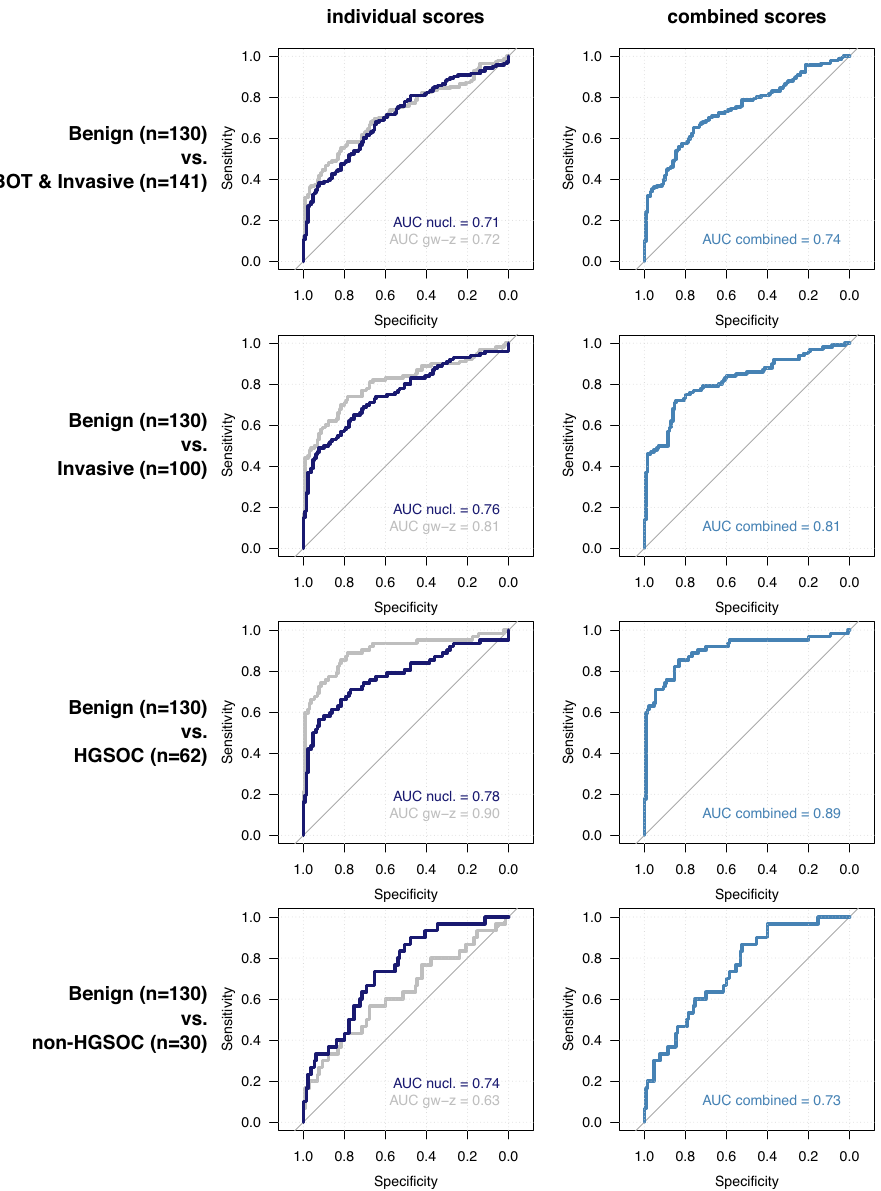
Fig. 3 ROC analysis. ROC curves for nucleosome scores ( “ nucl. ” ) and genome-wide z -scores ( “ gw- z ” ) to discriminate patients with benign ovarian disease ( n = 130) from patients with borderline (BOT) and invasive carcinoma ( n = 141, including 8 patients with metastases; fi rst row); patients with invasive carcinoma ( n = 100; second row); patients with HGSOC disease ( n = 62; third row); patients with non-HGSOC disease ( n = 30; fourth row). ROC curves for nucleosome and genome-wide z -scores were then combined in a single predictor and the optimism- corrected AUC value was calculated (second